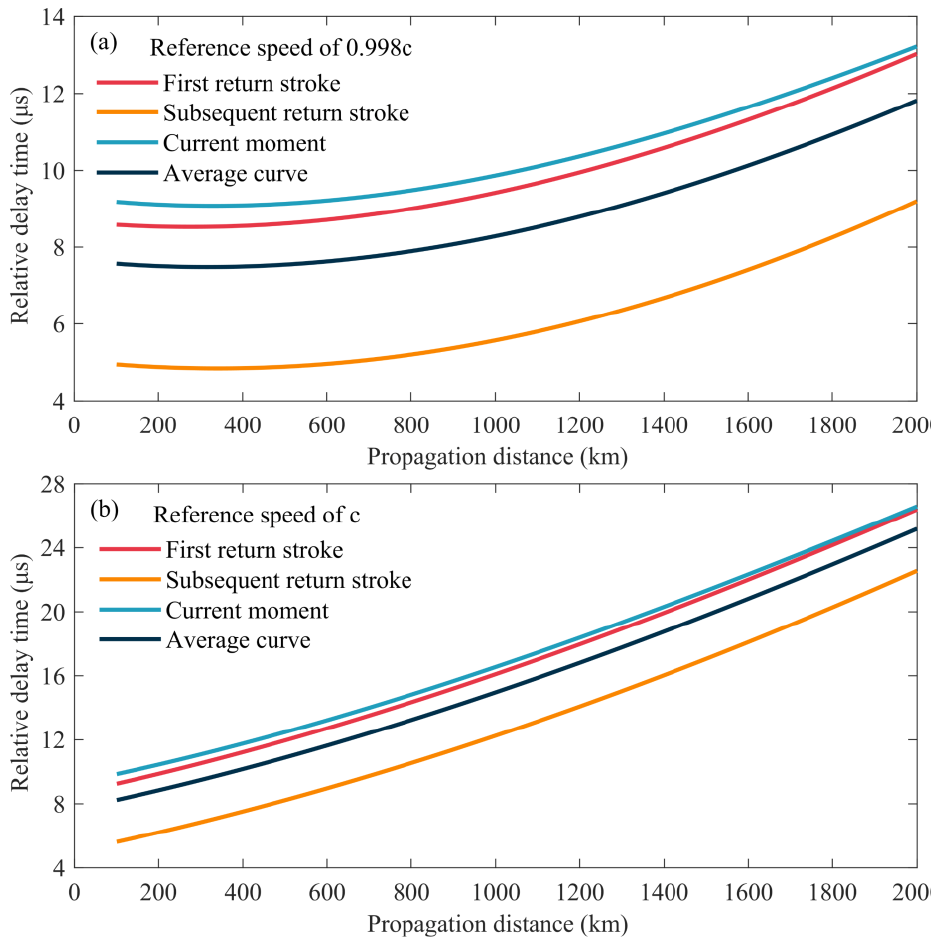
Figure 4. Relationship of the relative time delay versus propagation distance with different reference speeds. ( a ) The reference speed of 0.998 c . ( b ) The reference speed of c